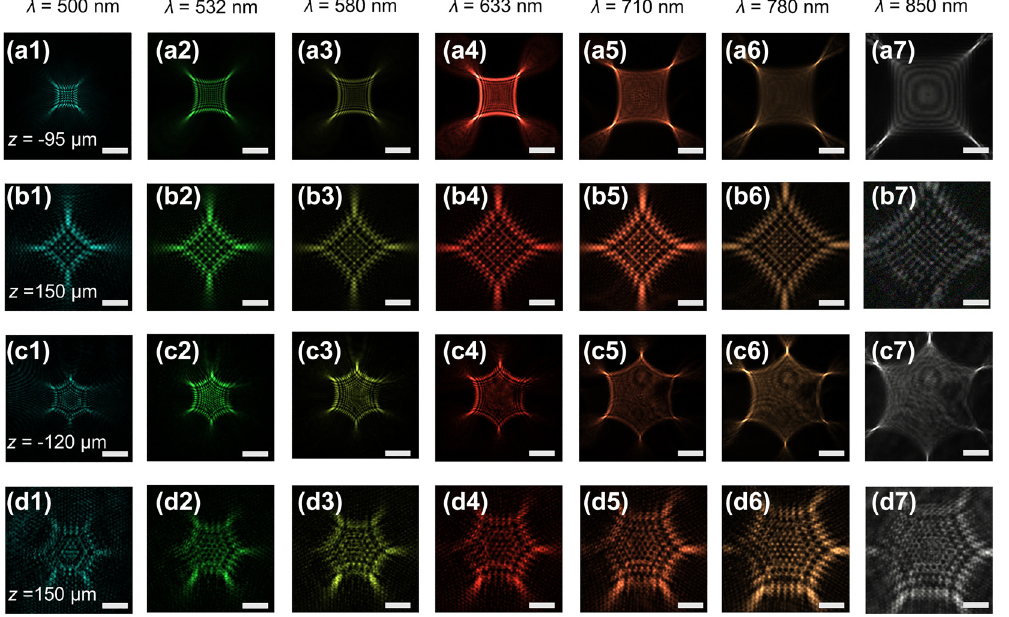
Figure 4: Measured intensity distributions of the PBs in x – y plane. Measured intensity distributions of the generated quadrilateral beams (a1) – (a7) for z = − 95 μ m and (b1) – (b7) for z = 150 μ m at wavelengths of λ = 500, 532, 580, 633, 710, 780 and 850 nm, respectively while, measured intensity distributions of the generated hexagon beams (c1) – (c7) for z = − 120 μ m and (d1) – (d7) for z = 150 μ m at wavelengths of λ = 500, 532, 580, 633, 710, 780, and 850 nm, respectively. Scale bar = 17 μ m (a1) – (a7), (b1) – (b7) and 20 μ m (c1) – (c7), (d1) –